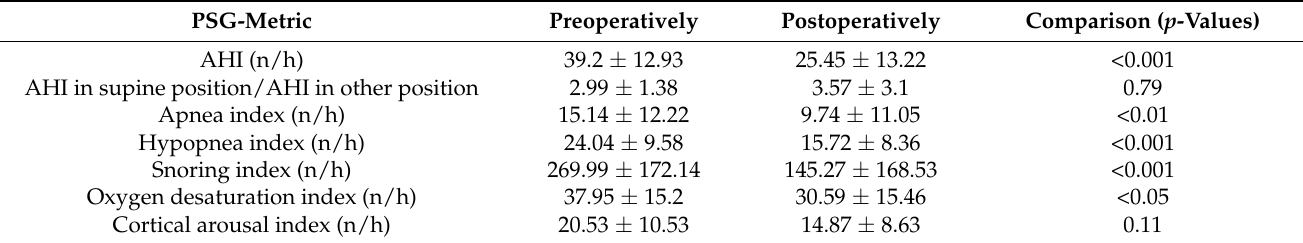
Table 1. Respiratory PSG-based parameters pre- and